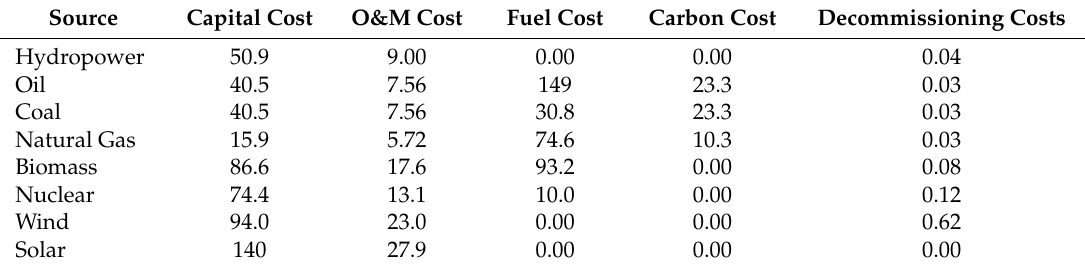
Table 5. Parameters for the LCOE calculation for each energy source for a discount rate of r = 10%